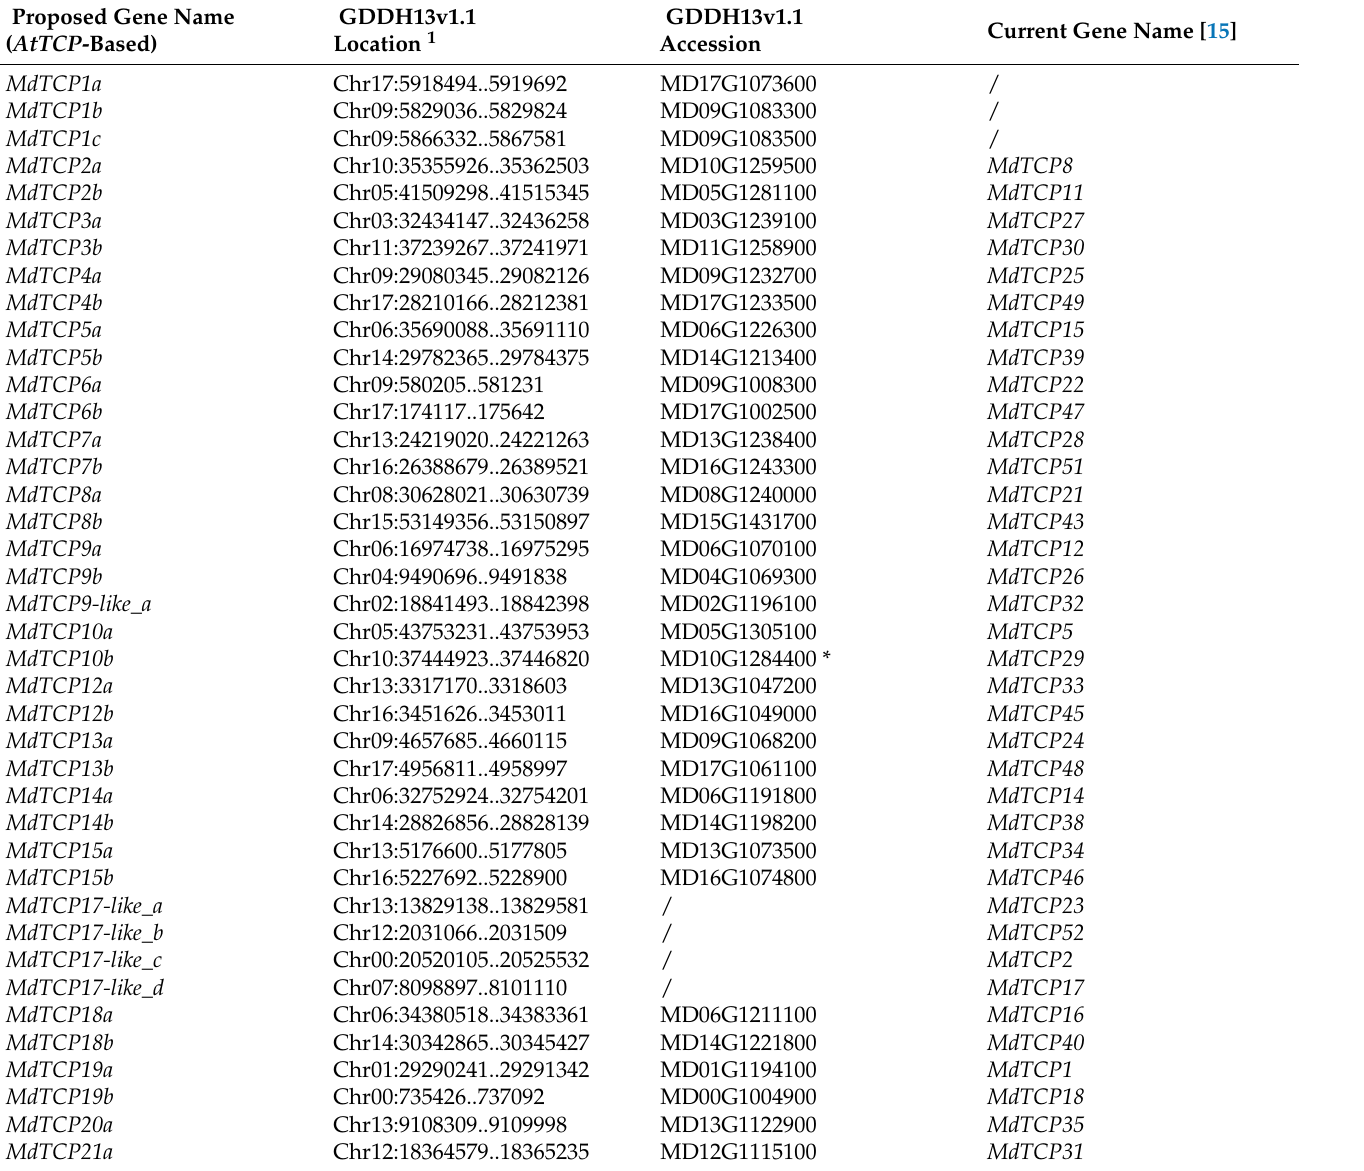
Table 2. Details of the 40 MdTCP sequences classified in the present work. The table lists the name of the genes determined on the homology with AtTCPs and the corresponding accession number and gene name as described by Xu and co-authors [15]. See Supplementary Materials (Table S1) for full